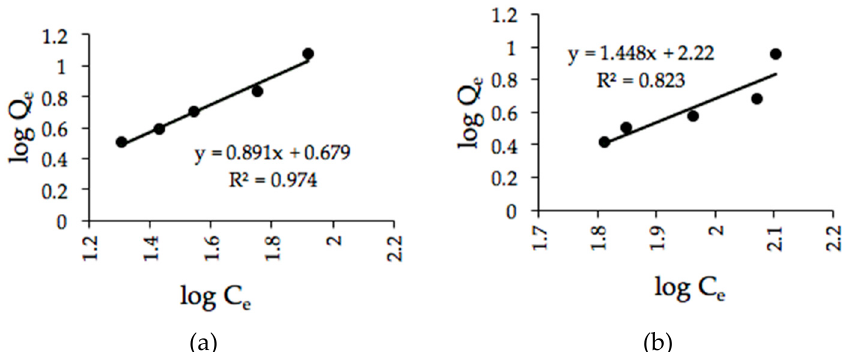
Figure 10. Freundlich isotherm plot fitted using POMB-retained ash: ( a ) microwave irradiated and ( b ) H 2 SO 4 –microwave irradiated. ( b ) H 2 SO 4 –microwave irradiated. Table 7. Freundlich adsorption isotherm